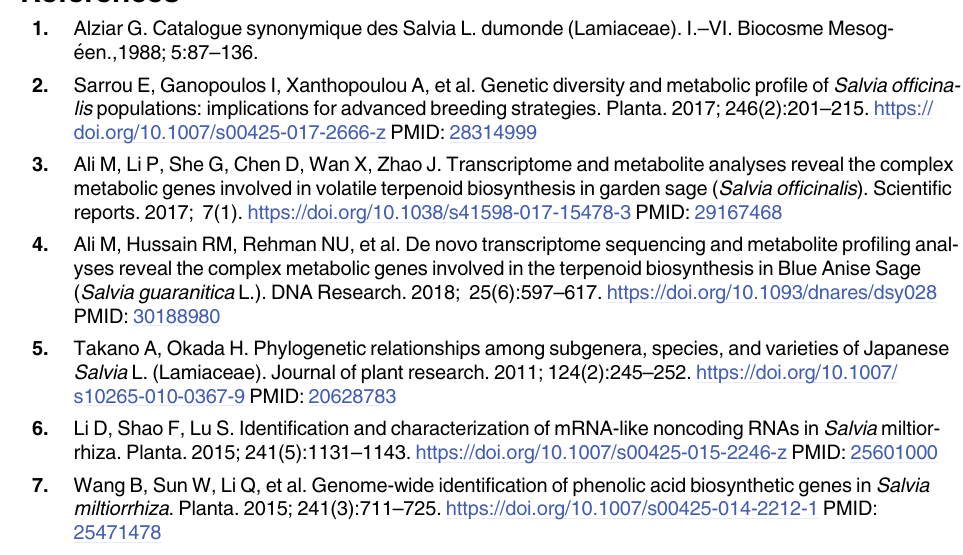
S1 Fig. Typical GC-MS mass spectrographs for terpenoids from leaf of A . thaliana plants.